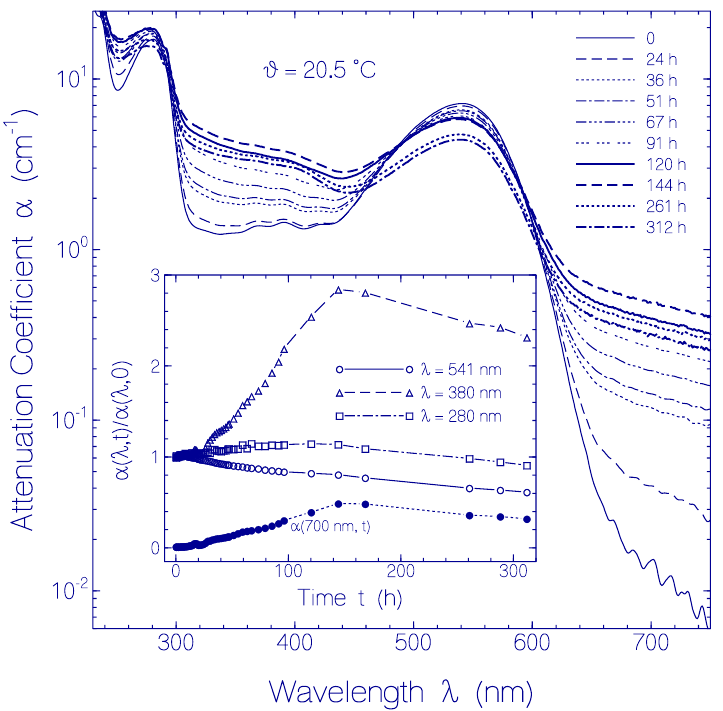
Figure 6. Temporal attenuation coefficient spectra development of CaRh in pH 7.3 HEPES/MOPS buffer at 20.5 °C. Main part: Attenuation coefficient spectra measured after indicated storage times. Inset: Attenuation coefficient ratio α ( λ , t )/ α ( λ , t = 0) for the wavelength λ = 541 nm (circles), 380 nm (triangles), and 280 nm (squares). The dots show the temporal attenuation coefficient development α ( λ = 700 nm) in the transparency region of CaRh.